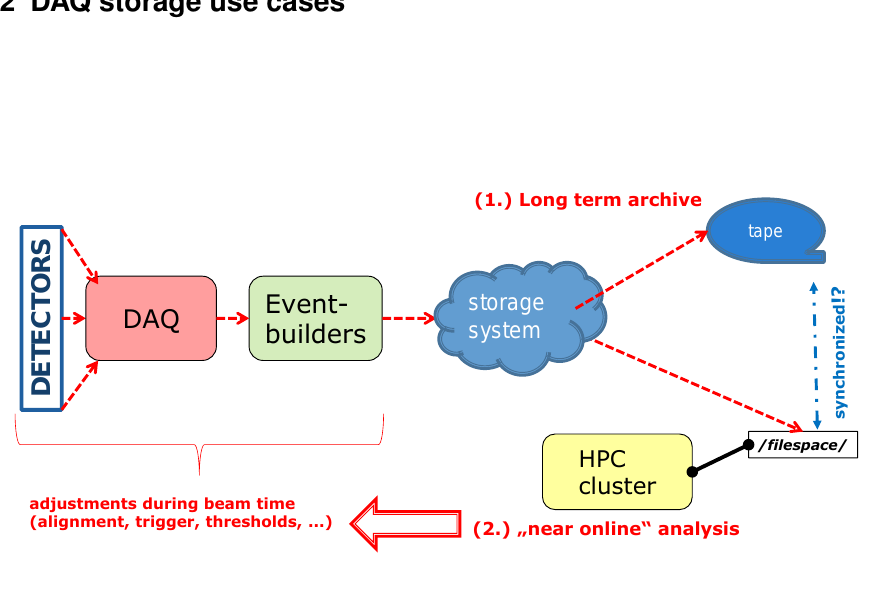
Figure 1. Use cases of a DAQ storage system: Raw data files produced by the event builders need to be written to a long term archive like a tape (1). Additionally, the same files are required at the filespace of an HPC cluster for a near online analysis during data taking